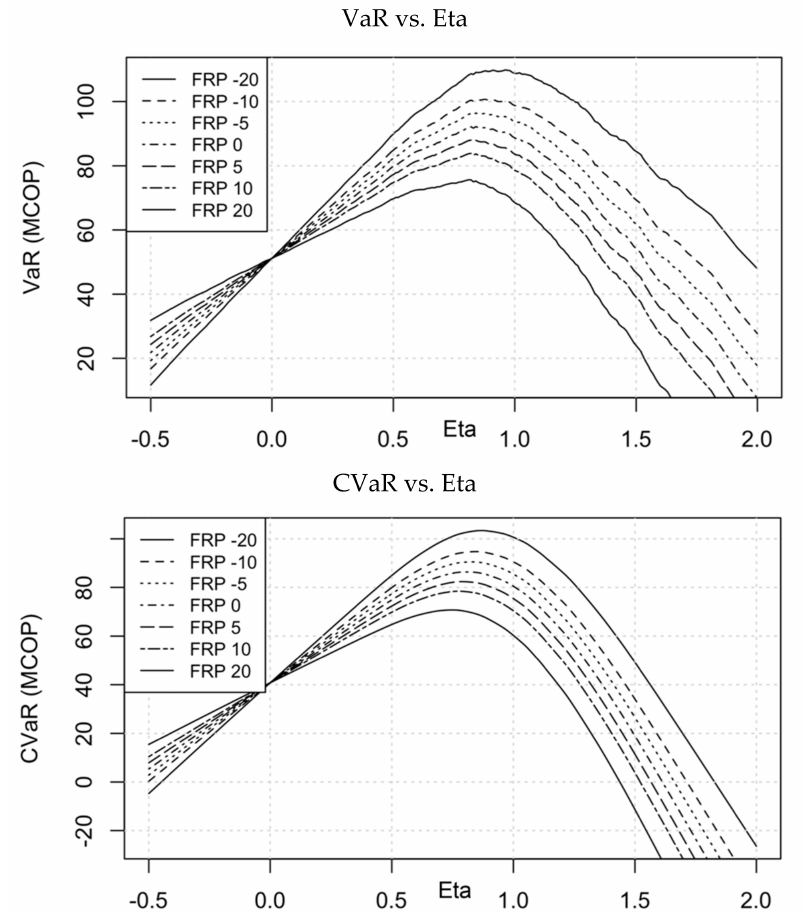
Figure 7. Sensitivity of the VaR and the CVaR to the Eta and FRP. Sensitivity of the value-at-risk (VaR) and conditional VaR (CVaR) to different contracting levels (Eta) and forward risk premium (FRP)